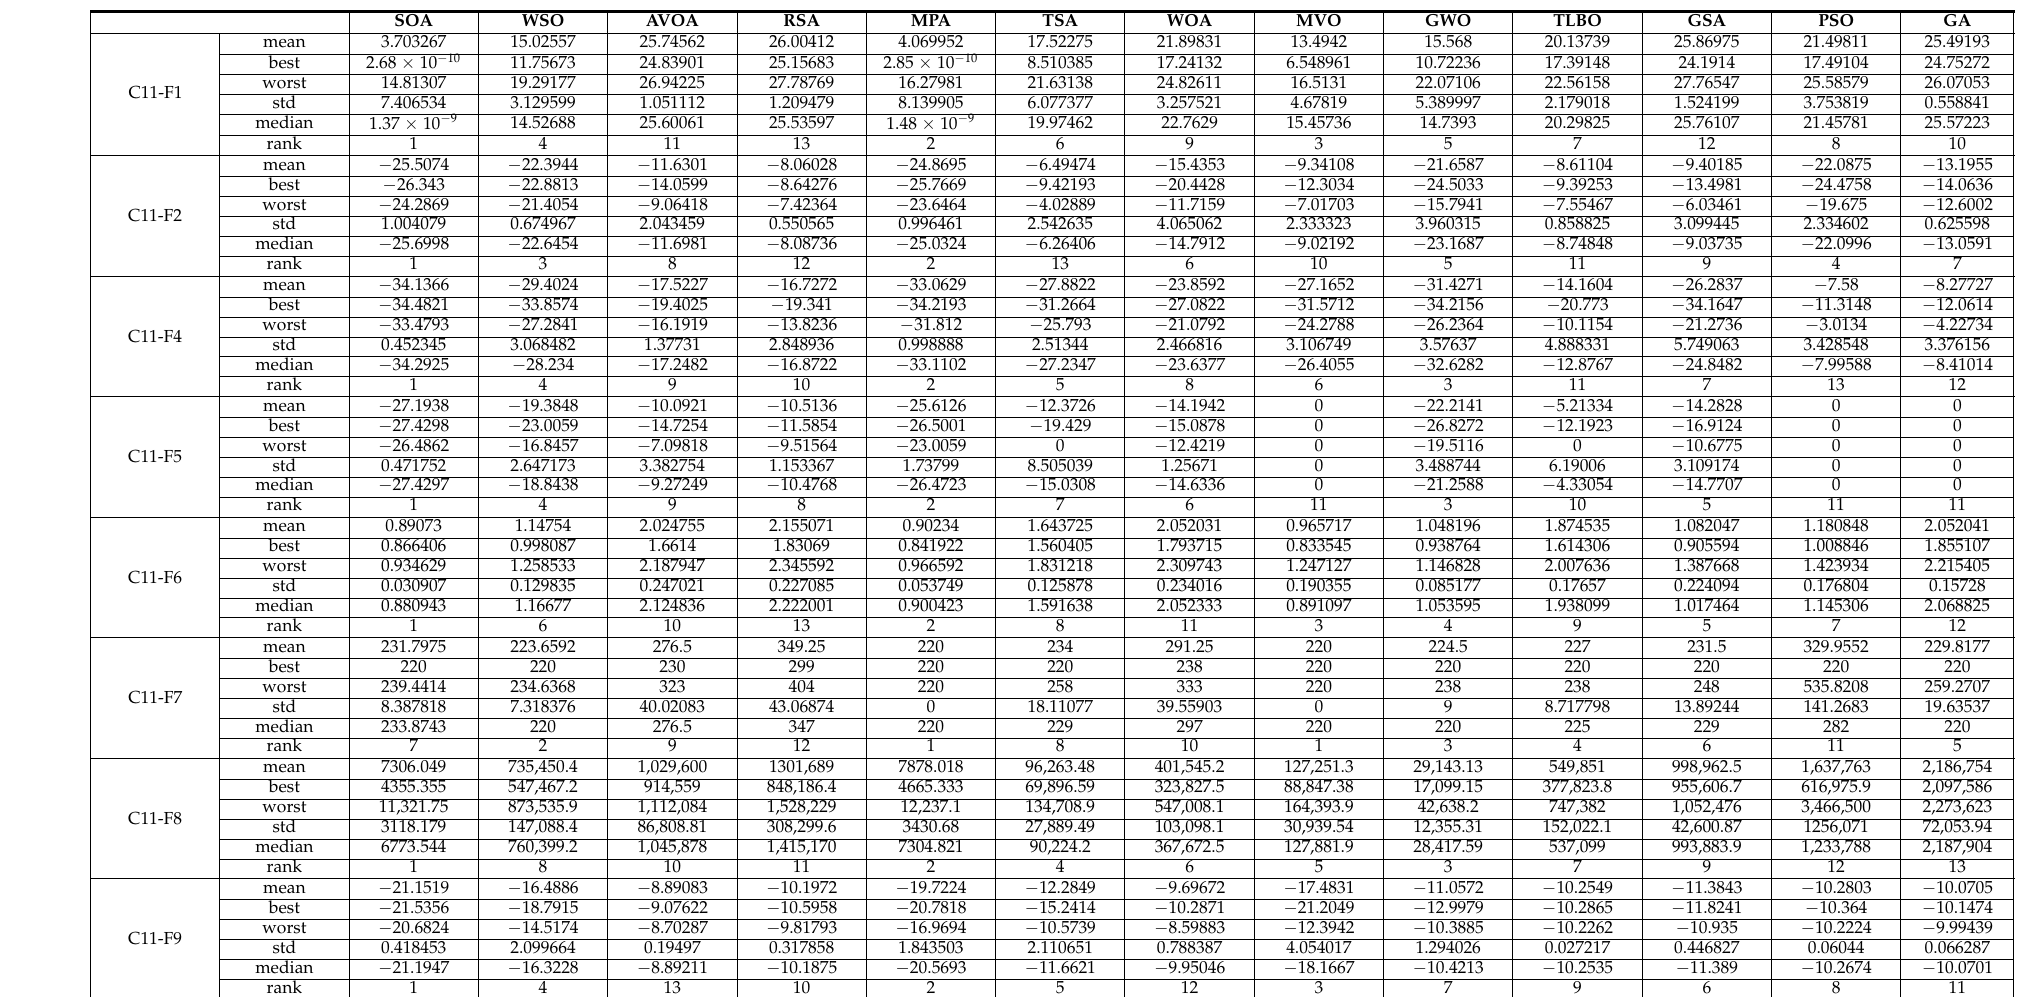
Table 8. Optimization results of the CEC 2011 test